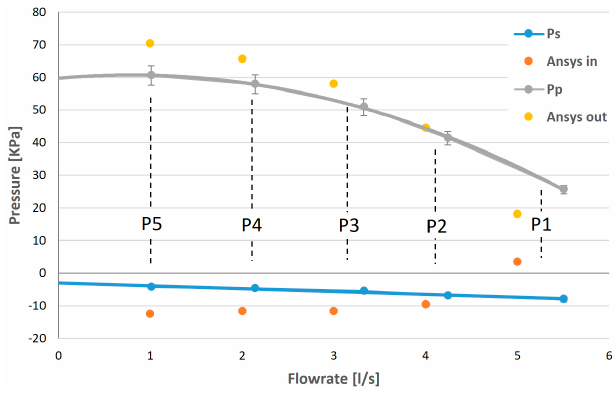
Figure 5. Graph of measured and calculated pressures.